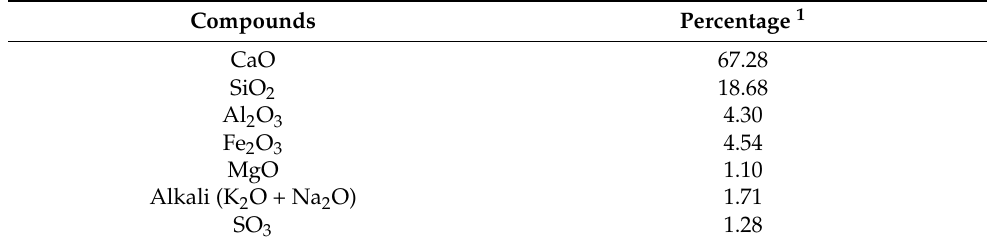
Table 3. Chemical composition of the cement.